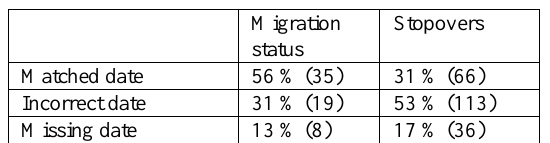
Table 1. Results of accuracy assessment The number in parenthesis indicates sample